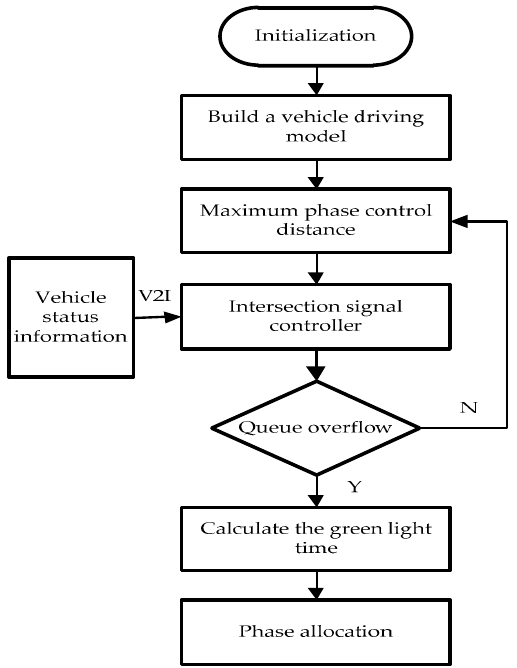
Figure 2. Queue overflow control scheme at intersection.